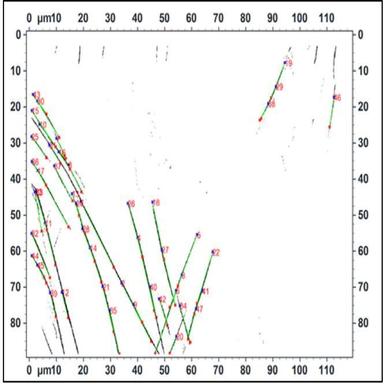
Binary image used for the slip line detection algorithm.